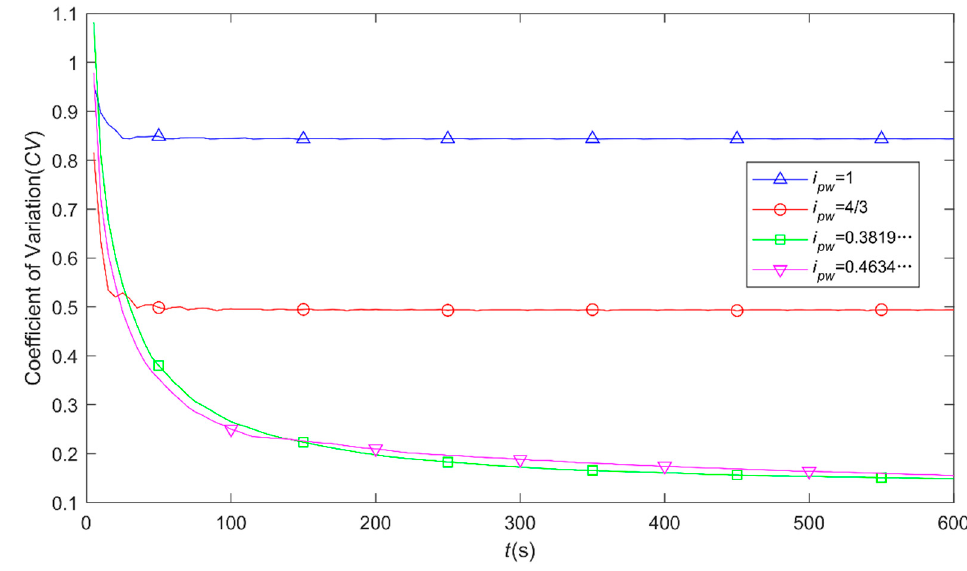
Figure 10. Variations of CV values by increasing the lapping time under different rotation speed ratios.